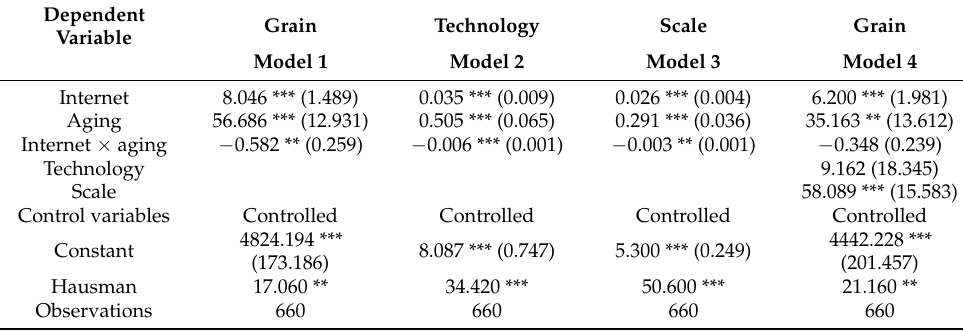
Table 4. Result of moderating effect